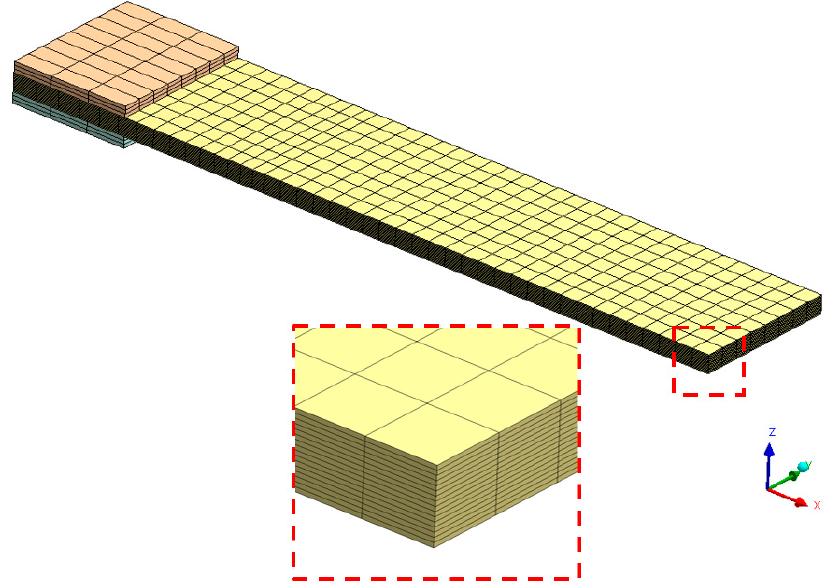
Figure 6. Mesh of the specimen in the numenrical model of the DCB delamination tests .